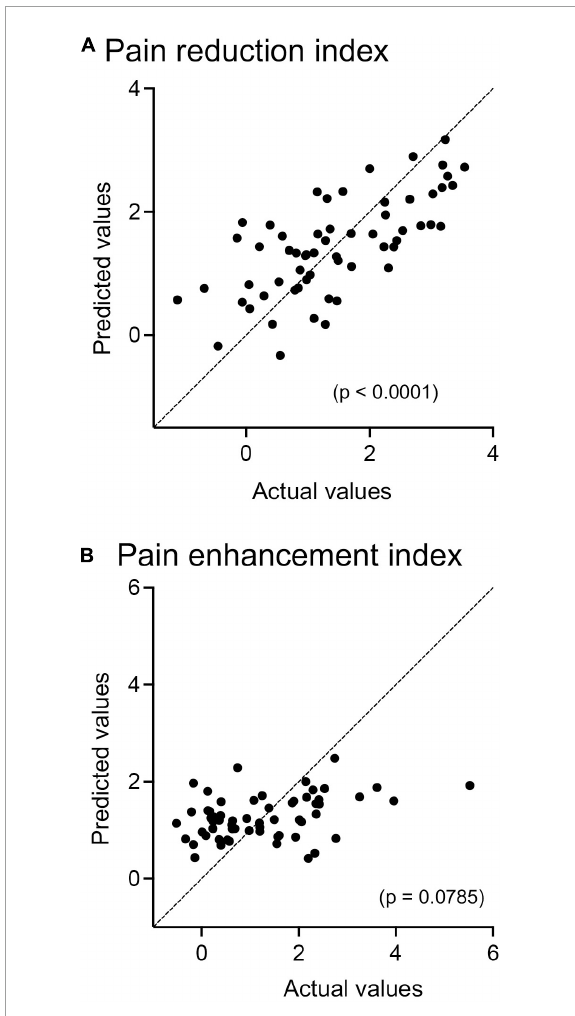
FIGURE6 Relationships between predicted and actual pain-reduction (A) and pain-enhancement (B) indices in multiple regression analyses with the forced entry method. (A) The model with the four predictor variables (sex, age, effect sizes of cerebral HbO responses to the LF sound in the right dl-PFC, and effect sizes of cerebral HbO responses to the LF sound in the left dl-PFC) significantly predicts pain reduction indices ( p < 0.0001). (B) The model with the four predictor variables (sex, age, effect sizes of cerebral HbO responses to the HF sound in the right dl-PFC, and effect sizes of cerebral HbO responses to the HF sound in the left dl-PFC) does not significantly predict pain enhancement indices ( p =